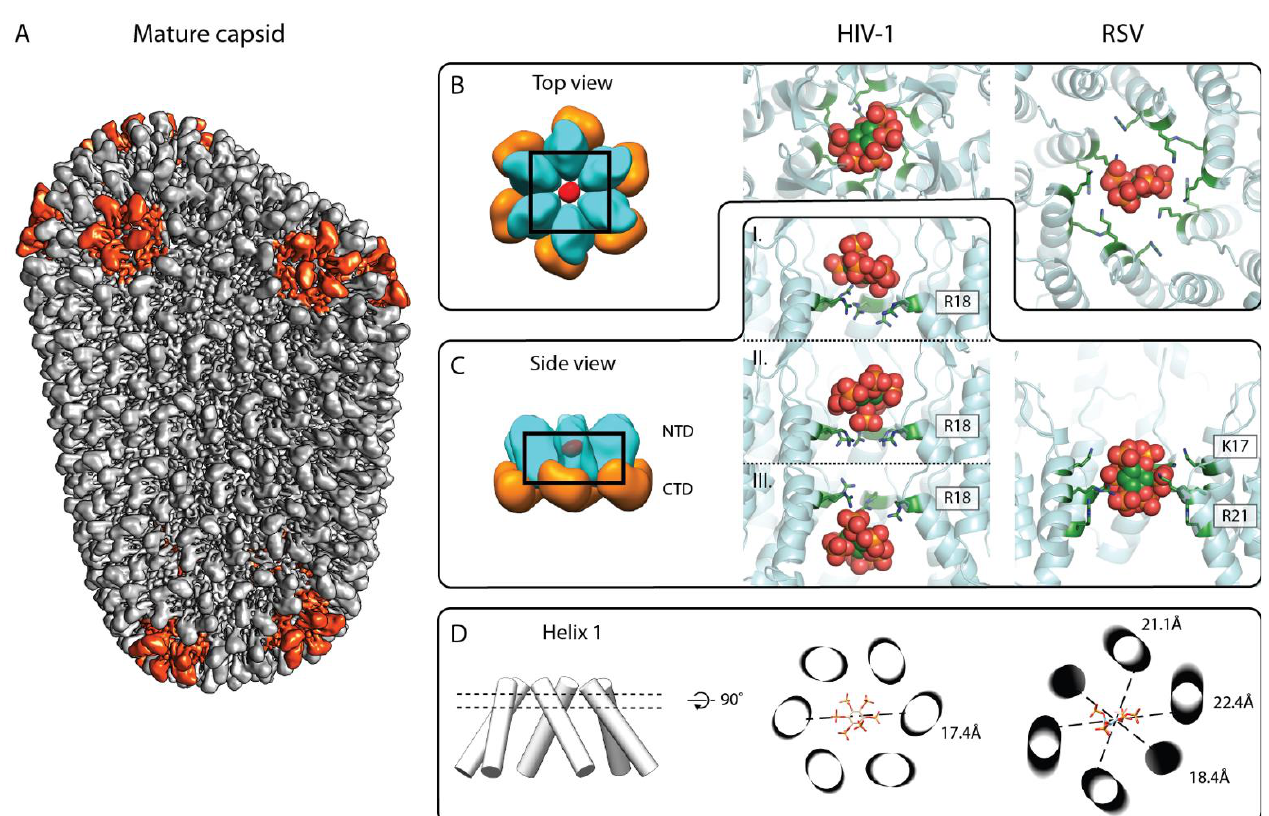
Figure 4. IP6 binding site in the mature retroviral CA lattice. ( A ) Composite isosurface representation of the mature CA lattice forming a conical core. Adapted from [37]. Grey: CA hexamers, red: CA pentamers. ( B , C ) Top and side view of the IP6 binding site in the mature CA hexamer, respectively. Left: schematic model of mature HIV-1 CA hexamer; cyan: CA NTD , orange: CA CTD , and red: IP6. Middle: X-ray crystallographic model of IP6 binding to mature HIV-1 CA hexamer (6BHS, top view). IP6 has been reported to bind at different heights of the HIV-1 CA NTD pore, based on different crystal structures, shown in ( C ) (pdb: 6BHT (top and bottom), 6BHS (middle)). Right: model of IP6 binding in the RSV CANC hexamer, derived from a structure solved by cryo-ET and subtomogram averaging (pdb: 7NO2). Note the orientation of the IP6 molecule with four axial phosphates pointing up or down, and one axial and the equatorial phosphate pointing horizontally. The color coding for CA NTD is as in the left panel. The IP6 molecule is shown in sphere representation in green, orange, and red. The arginines and lysines coordinating the IP6 molecule are shown in a green stick representation and are annotated. ( D ) Helix 1 orientation with respect to IP6 binding. Left: cylinder model of the central pore formed by helix 1. Middle and right: cross-section through helix 1 cylinders at the height of IP6 binding plane for the C6 symmetric HIV-1 CA hexamer (as seen in the middle panel of B) and the C2 symmetric RSV CA hexamer (as seen in the right panel of B), respectively. IP6 is shown as a stick model. Dashed lines show distances between the opposite C α atoms of R18 of HIV-1 CA in the middle image and K17 of RSV CA in the right image, and emphasize the deviation of the RSV hexamer from sixfold symmetry.